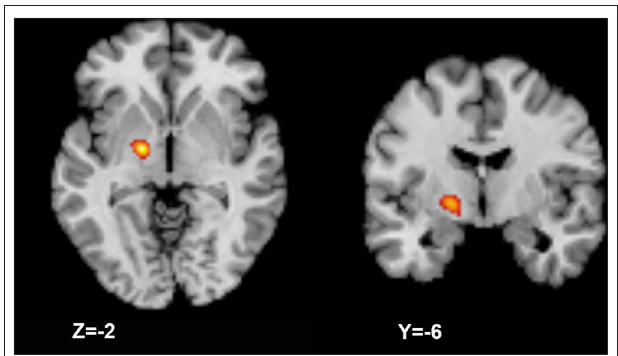
FIGURE 3 | Activation likelihood estimation (ALE) meta-analysis result. The meta-analysis result shows a larger gray matter volume in the left globus pallidus (axial and coronal